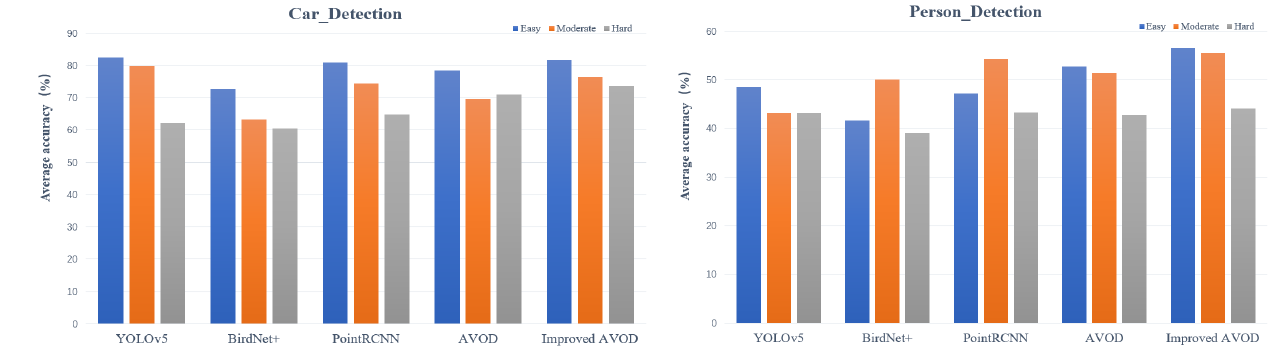
Figure 13. Comparison of performance indexes of detection accuracy of each algorithm.